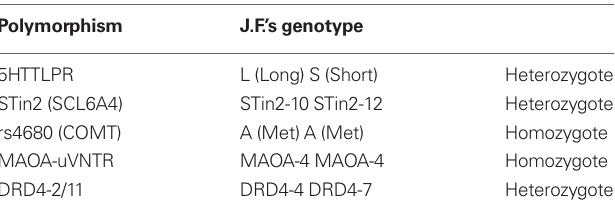
Table 3 | genotypes identified in